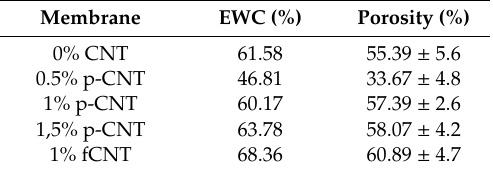
Table 1. Effect of carbon nanotube (CNT) loading on ultrafiltration characteristic of membranes.